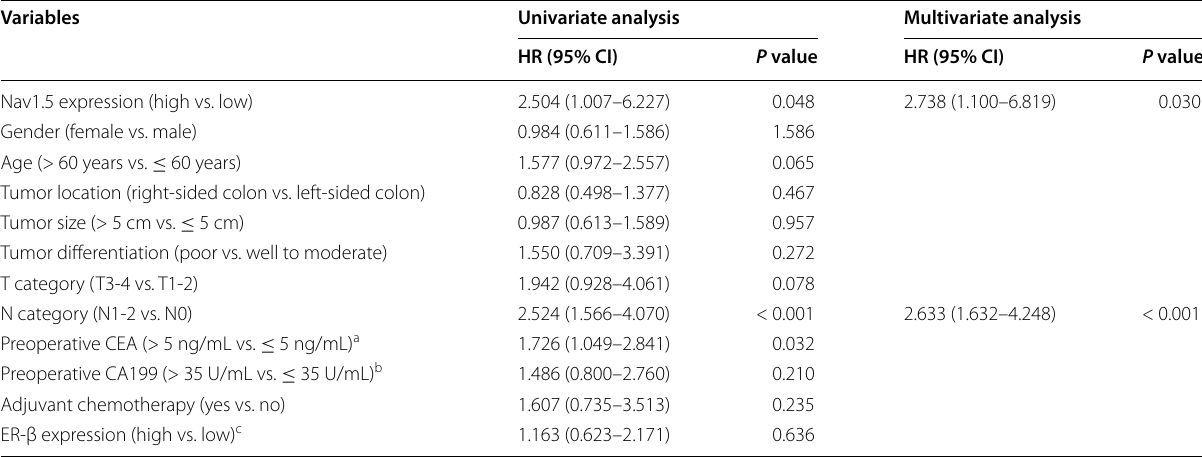
Table 2 Univariate and multivariate Cox regression analyses of prognostic predictors for 5-year disease-free survival